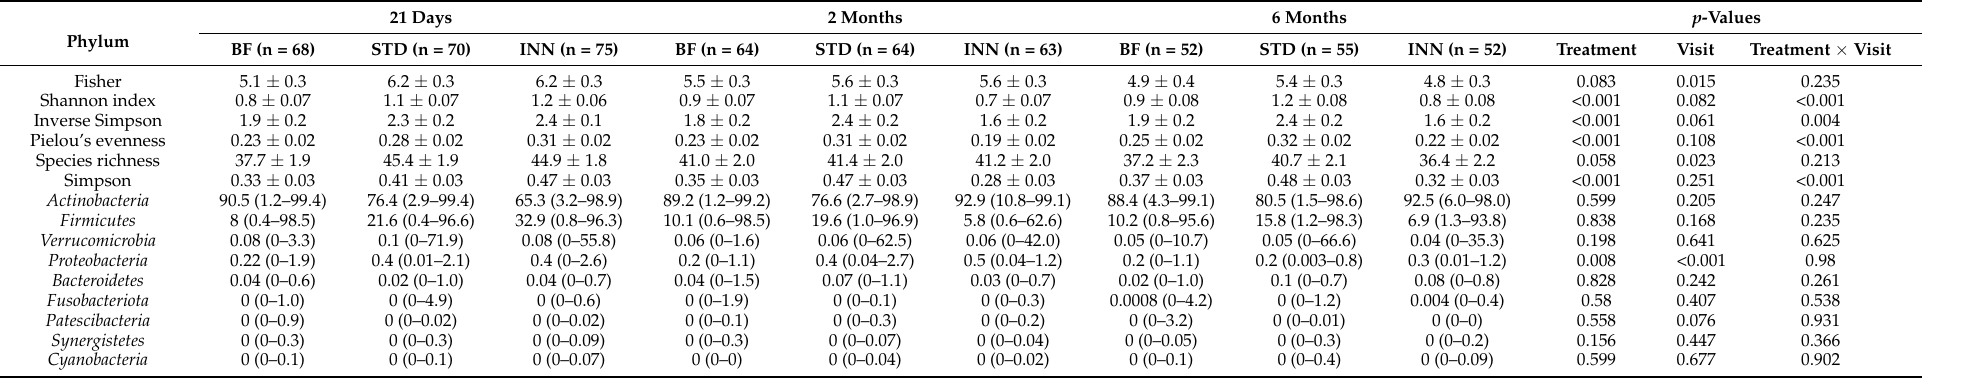
Table 1. Relative abundances at the phylum levels of fecal bacteria in infants fed the INNOVA (INN) or a standard formula (STD) compared to exclusive breastfed (BF) infants up to 6 months of